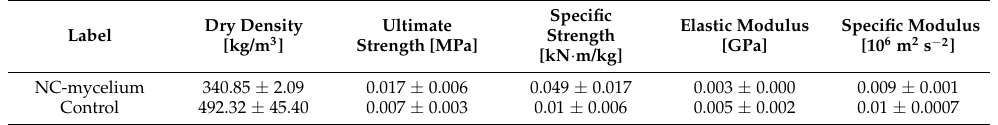
Figure 12. Internal bond strength of nanoclay–mycelium composite. Labels with different letters indicate a statistical difference ( p < 0.05) among the specimens.